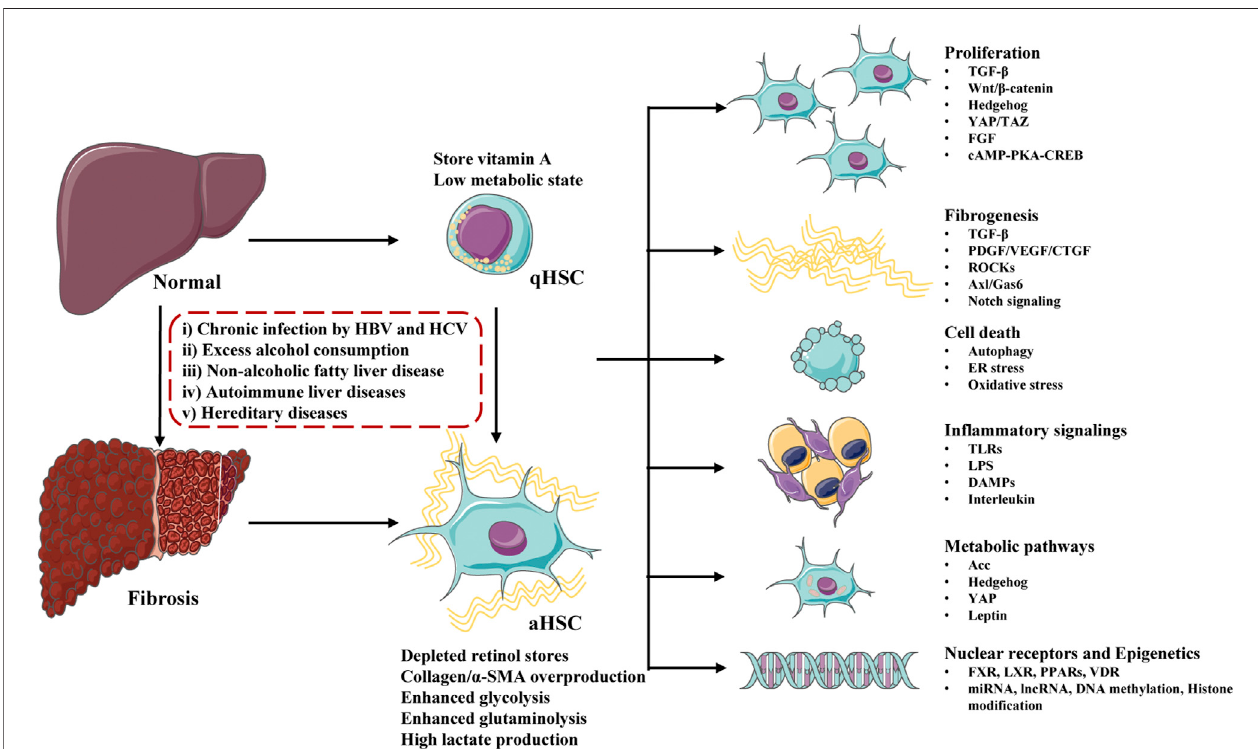
FIGURE 2 | Major molecules and signaling pathways regulating hepatic stellate cells (HSCs) activation and liver fi brosis. Undergo physiological conditions, HSCs exist as a quiescent phenotype (qHSCs), which store vitamin A and stay in a low metabolic state. After stimulating by a serious of factors (including chronic infection, excess alcohol consumption, non-alcoholic fatty liver disease, autoimmune liver diseases and hereditary diseases), qHSCs activate into activated HSCs (aHSCs) and liver fi brosis develop. Activated HSCs lose stored retinol, produce excessive collagen/ α -SMA and stay at a high metabolic state. HSCs activation is regulated by a number of signaling pathways and molecules, including proliferation, fi brogenesis, cell death, in fl ammatory signalings, metabolic pathways, nuclear receptors and